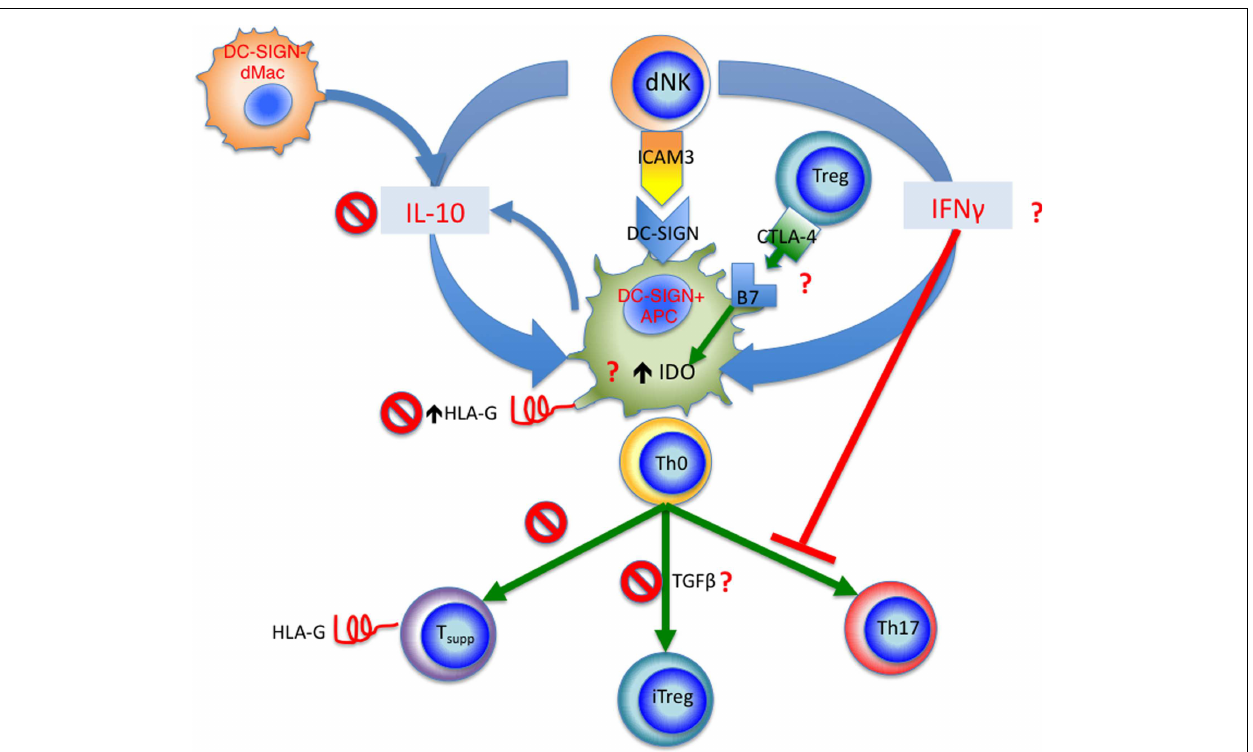
passed onto activatedT cells via trogocytosis, resulting in accumulation of CD4 + HLA-G + T suppressor cells. In pre-eclampsia, several check points are affected as marked by the “No symbol.”These include reduced IL-10 level, reduced HLA-G expression by DC-SIGN + APCs, reduced generation of CD4 + HLA-G + T suppressor cells, and reduced iTreg cell induction. Other yet unknown mechanisms may also be affected in pre-eclampsia marked by the red question mark, including IFN γ production by dNKs, CTLA-4 expression by Treg cells and interaction with B7 molecules, as well as IDO expression and TGF β production by DC-SIGN +